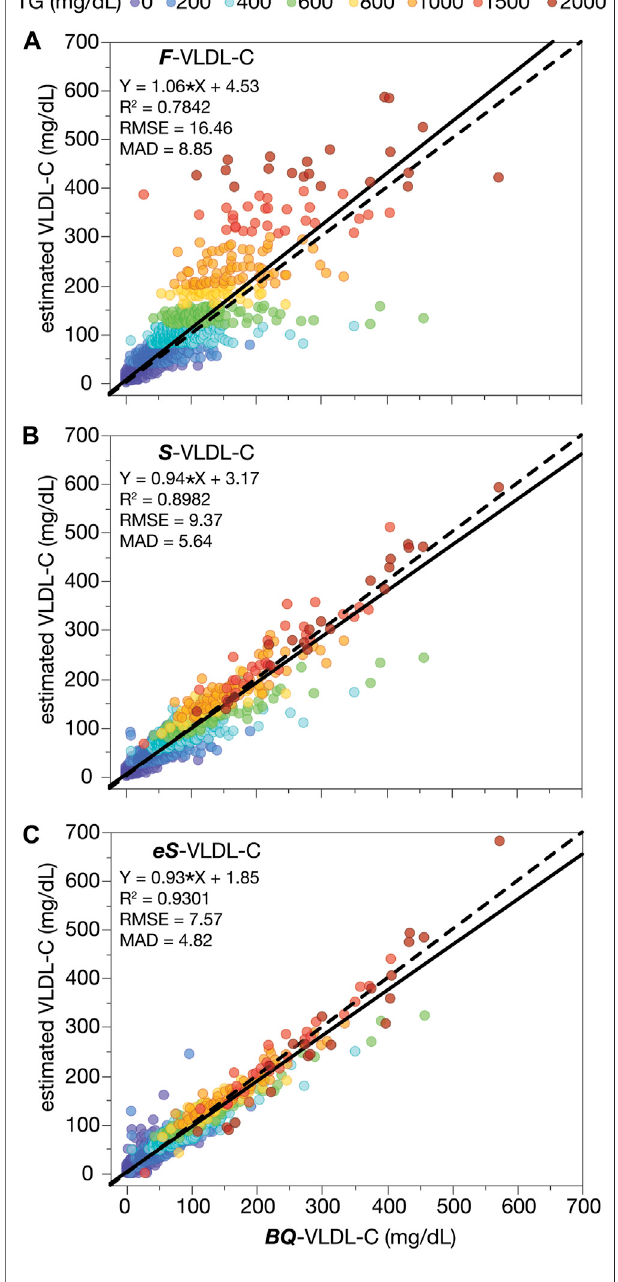
FIGURE 3 | VLDL-C by calculation versus β -quanti fi cation. VLDL-C was calculated from the results of astandard lipid panel in the validation dataset (N = 12,405) by the Friedewald VLDL-C formula ( F -VLDL-C) (A) , the Sampson VLDL-C equation ( S- VLDL-C) (B) , and the enhanced Sampson VLDL-C equation ( eS -VLDL-C) (C) and plotted against VLDL-C as measured by BQ. Solidlinesarethelinear fi tforindicatedregressionequations.Dashedlinesare the line of identity. Results are color-coded by TG levels with the value in the legend indicating the start of each